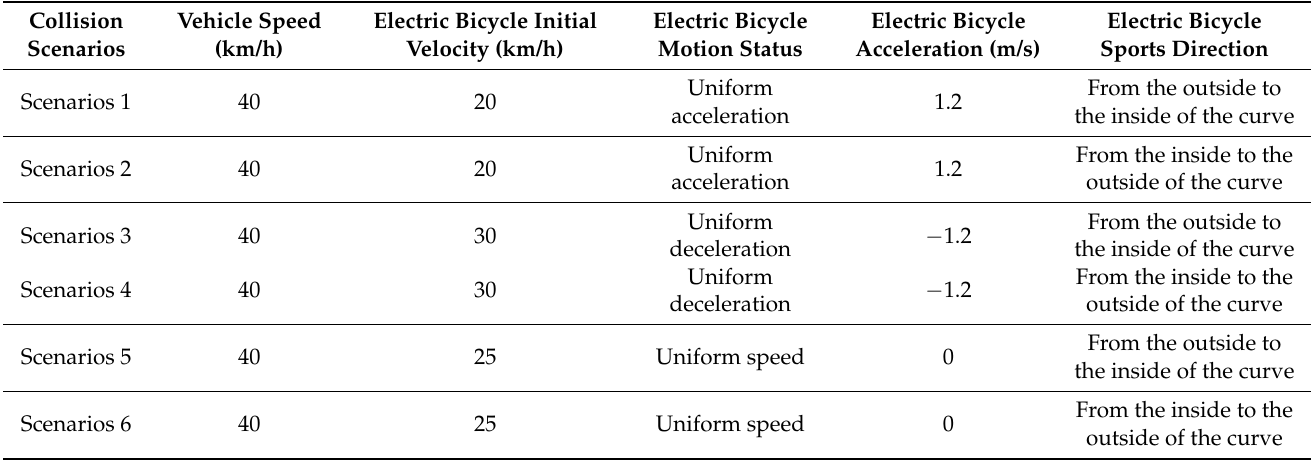
Table 1. Specific Parameters of Crash Test Scenarios.